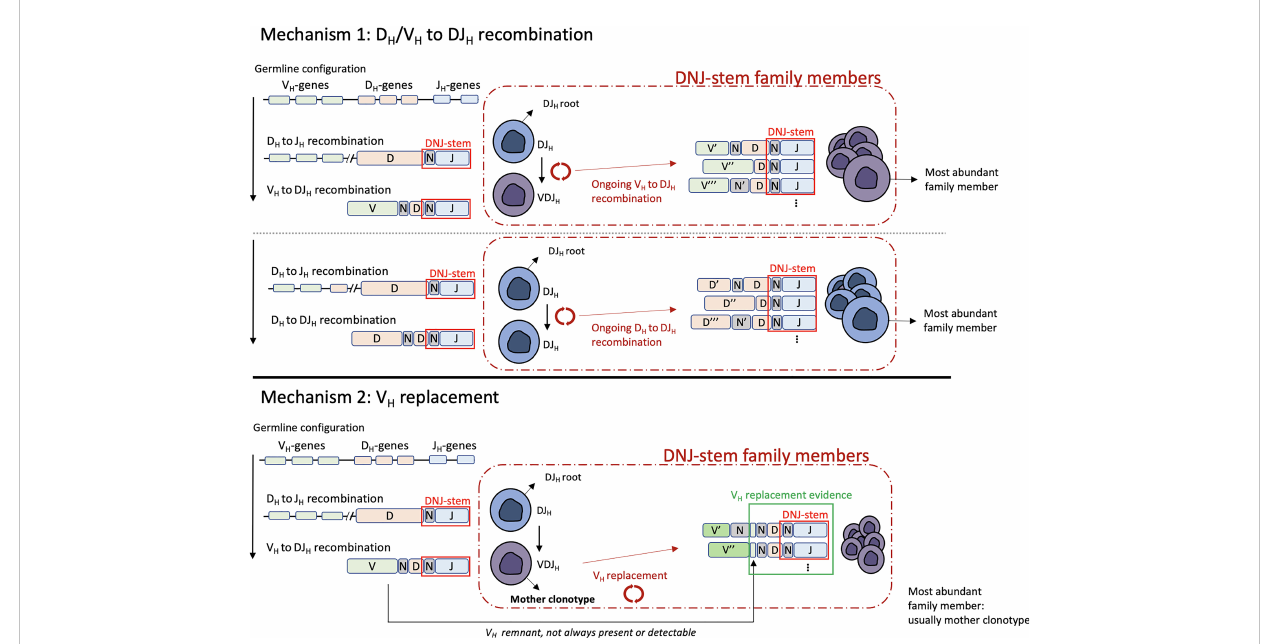
FIGURE 3 Schematic visualization of the terminology used in this study and the two mechanisms driving clonal evolution: D H /V H to DJ H recombination (top) and V H replacement (bottom). All DNJ-stem family members, including the DJ H root, the VJ H mother clonotype (V H replacement) carry the same DNJ sequence (red box). Evidence of V H replacement (see main text) is not always present or detectable due to further recombination-related nucleotide sequence trimming (green